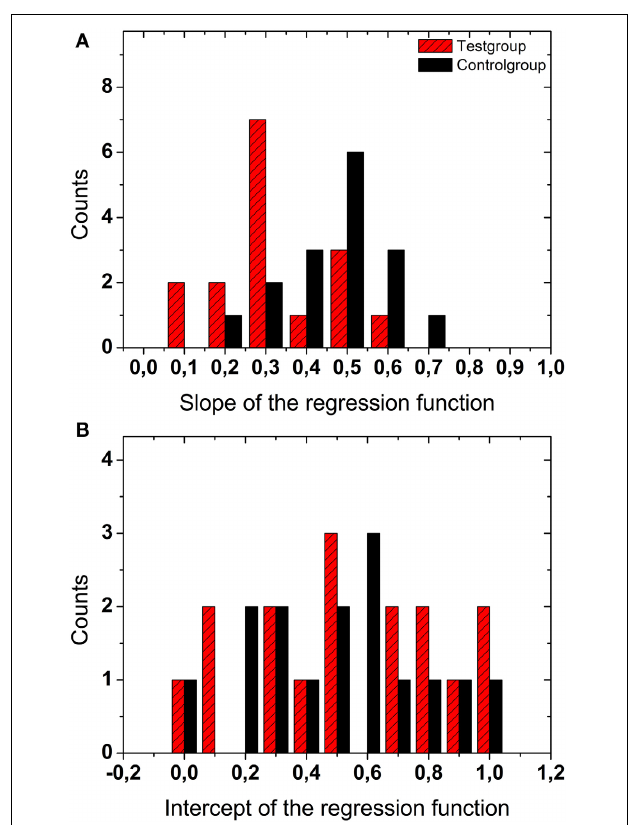
FIGURE 3 | Regression data. The top panel (A) shows a histogram of the slopes of the linear regressions for all display durations and all numbers of dots for the test group (red hatched bars) and the control group (black bars). The bottom panel (B) shows the data for the intercepts of the regression